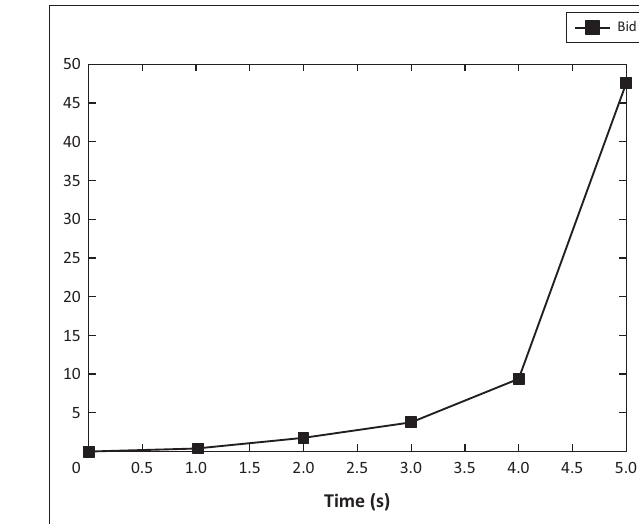
FIGURE 3: Plot of B